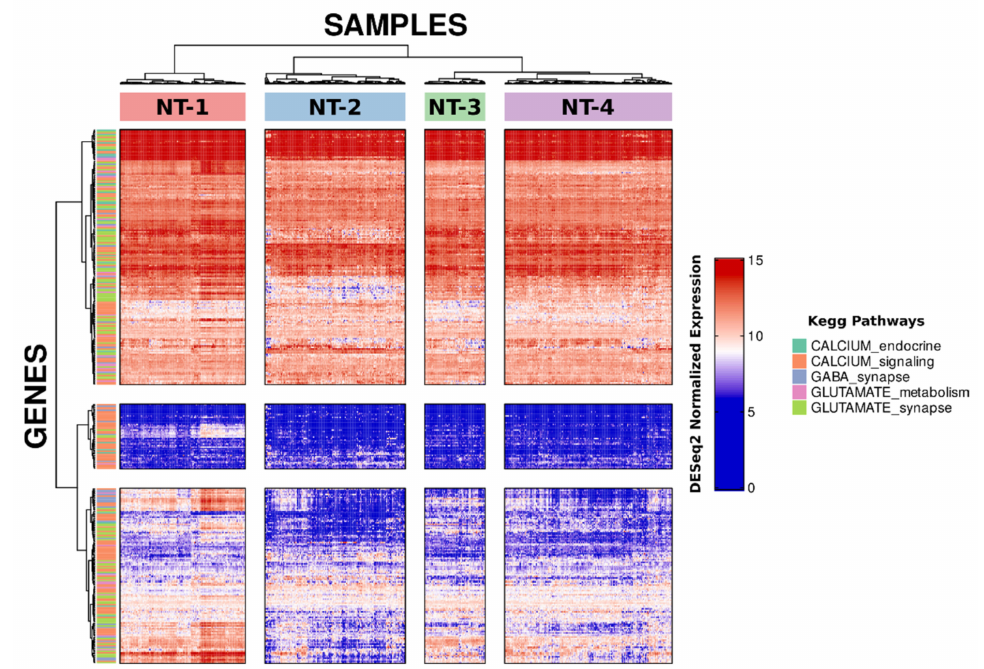
Figure 1. GABA, glutamate and calcium pathway-related gene expression signatures of 661 TCGA gliomas samples. Four clusters were generated by hierarchical unsupervised clustering using Pearson correlation (glioma samples in column) and Minkowski distance (genes in rows). Ward.D2 clustering method was selected for this clustering. Colors in rows represent different KEGG metabolic pathways of the included neurotransmission